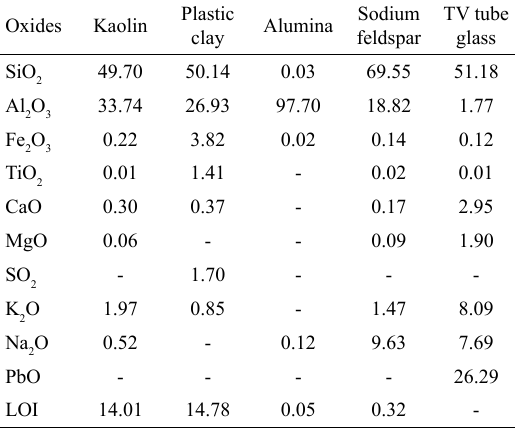
Table 3. Chemical composition of the raw materials (wt.%). Plastic Oxides Kaolin clay